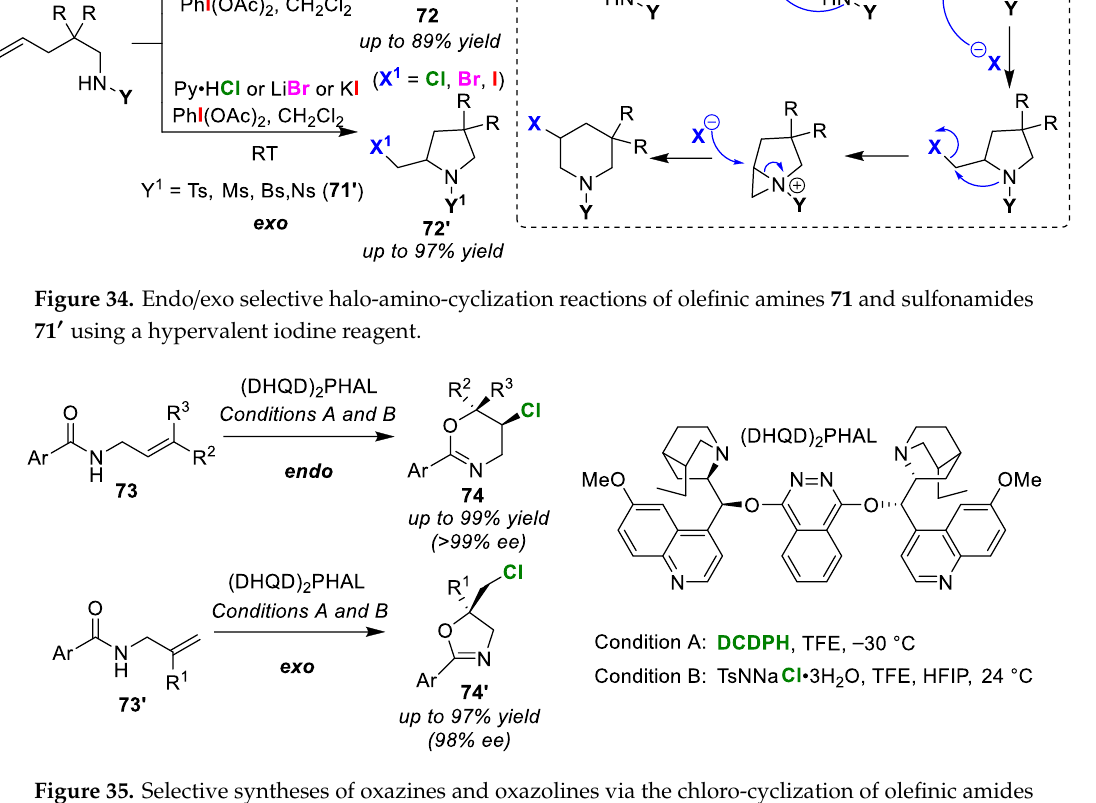
Figure 34. Endo/exo selective halo-amino-cyclization reactions of olefinic amines 71 and sulfonamides 7 1′ using a hypervalent iodine reagent.